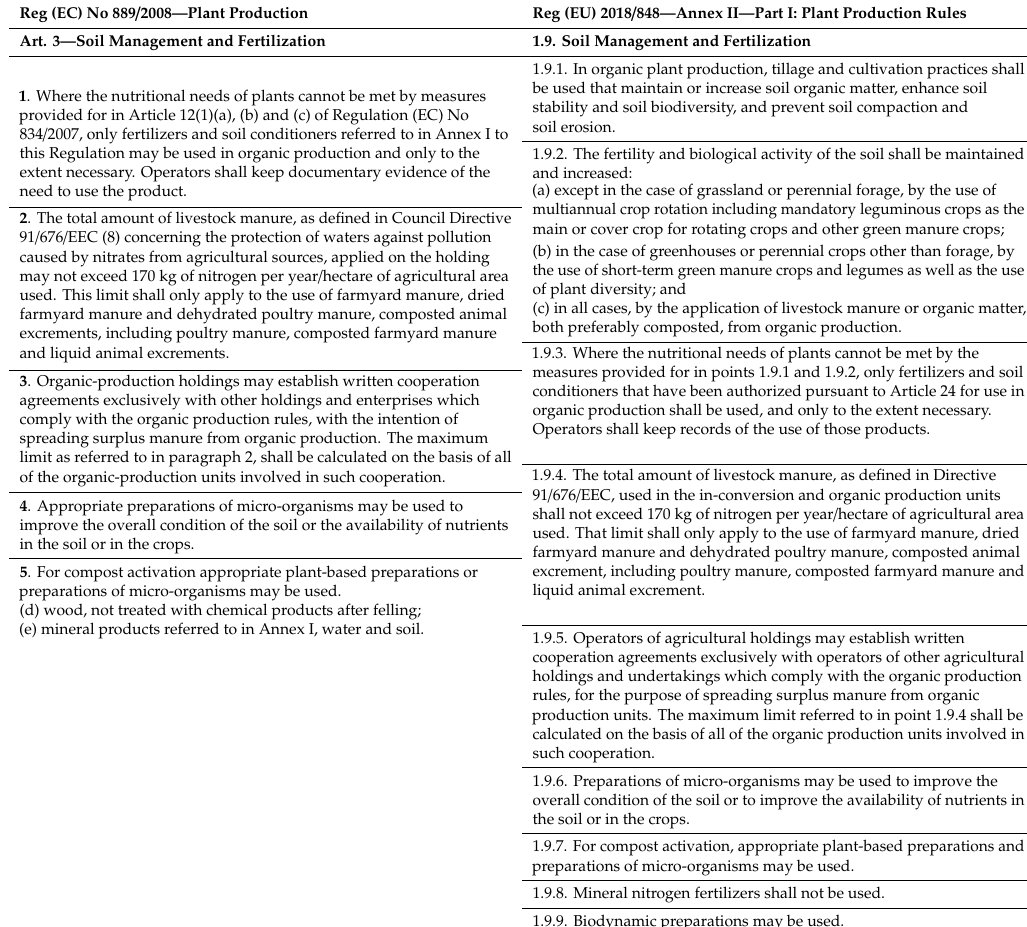
Table 1. Comparison of main criteria for soil management and fertilization in Reg (EC) No 889 / 2008 and Reg (EU) 2018 /